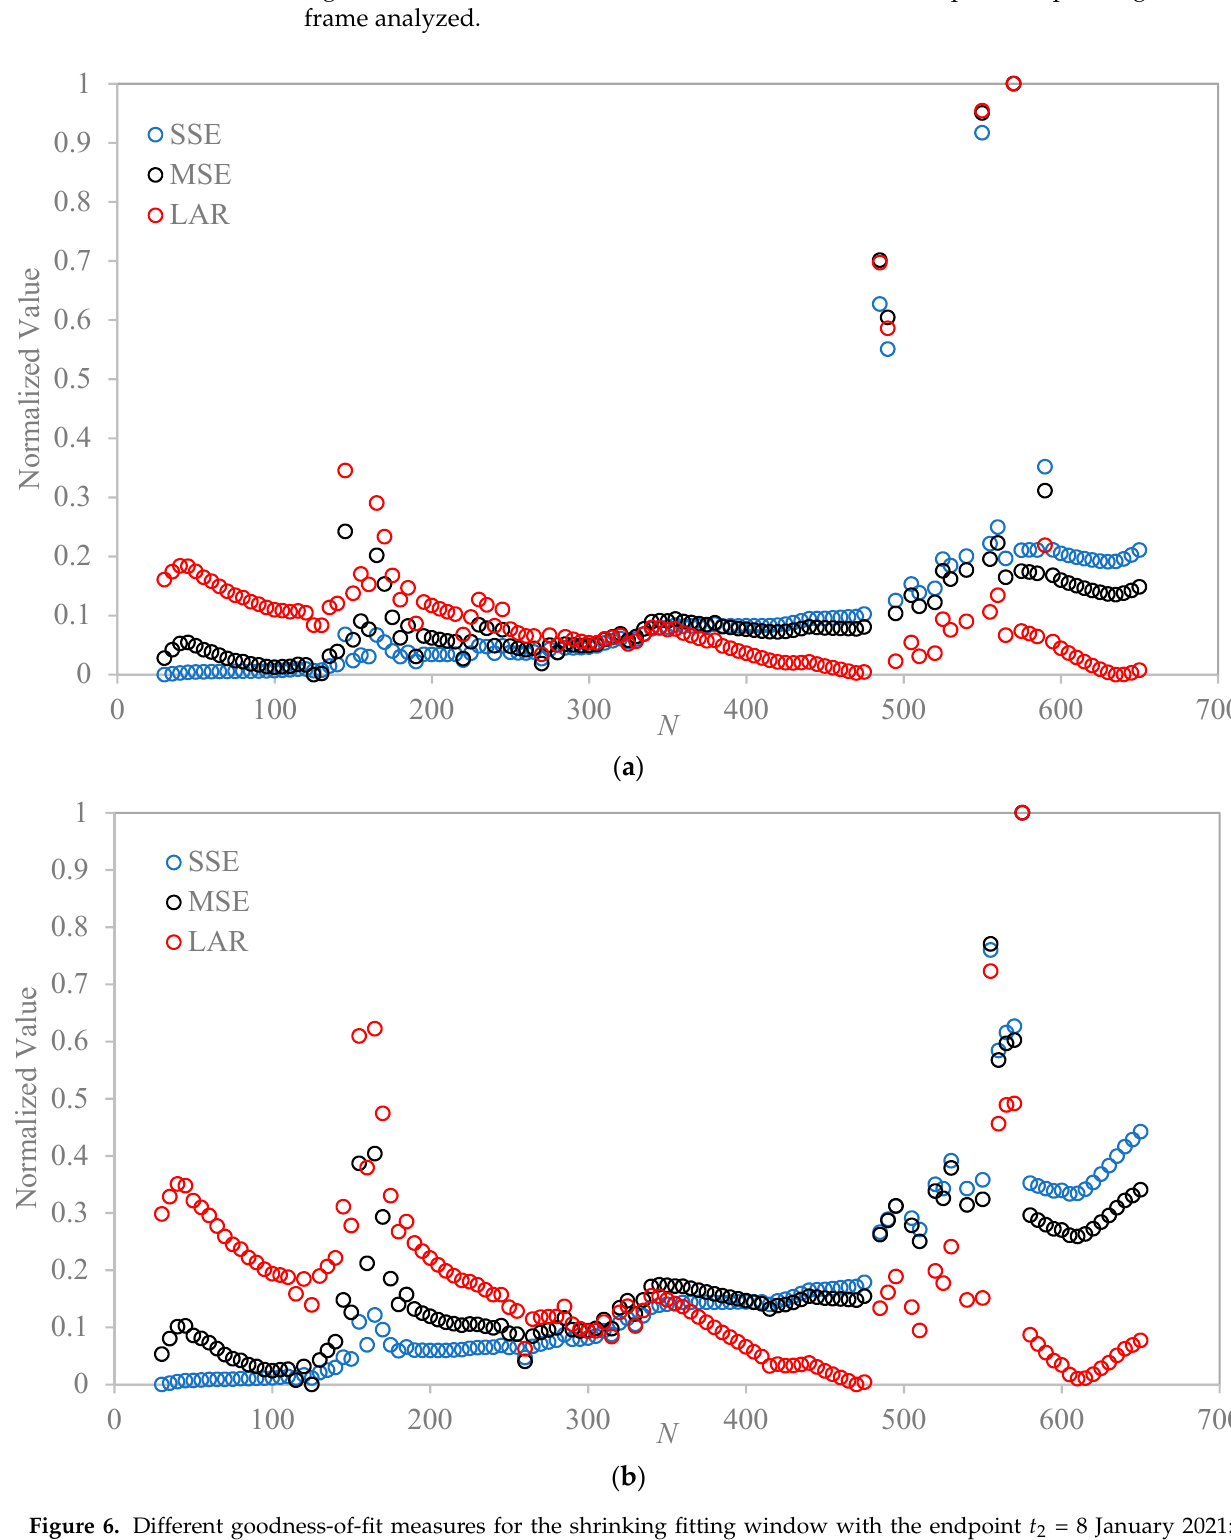
Figure 6. Different goodness-of-fit measures for the shrinking fitting window with the endpoint t 2 = 8 January 2021: ( a ) outliers are not removed; ( b ) outliers are removed.